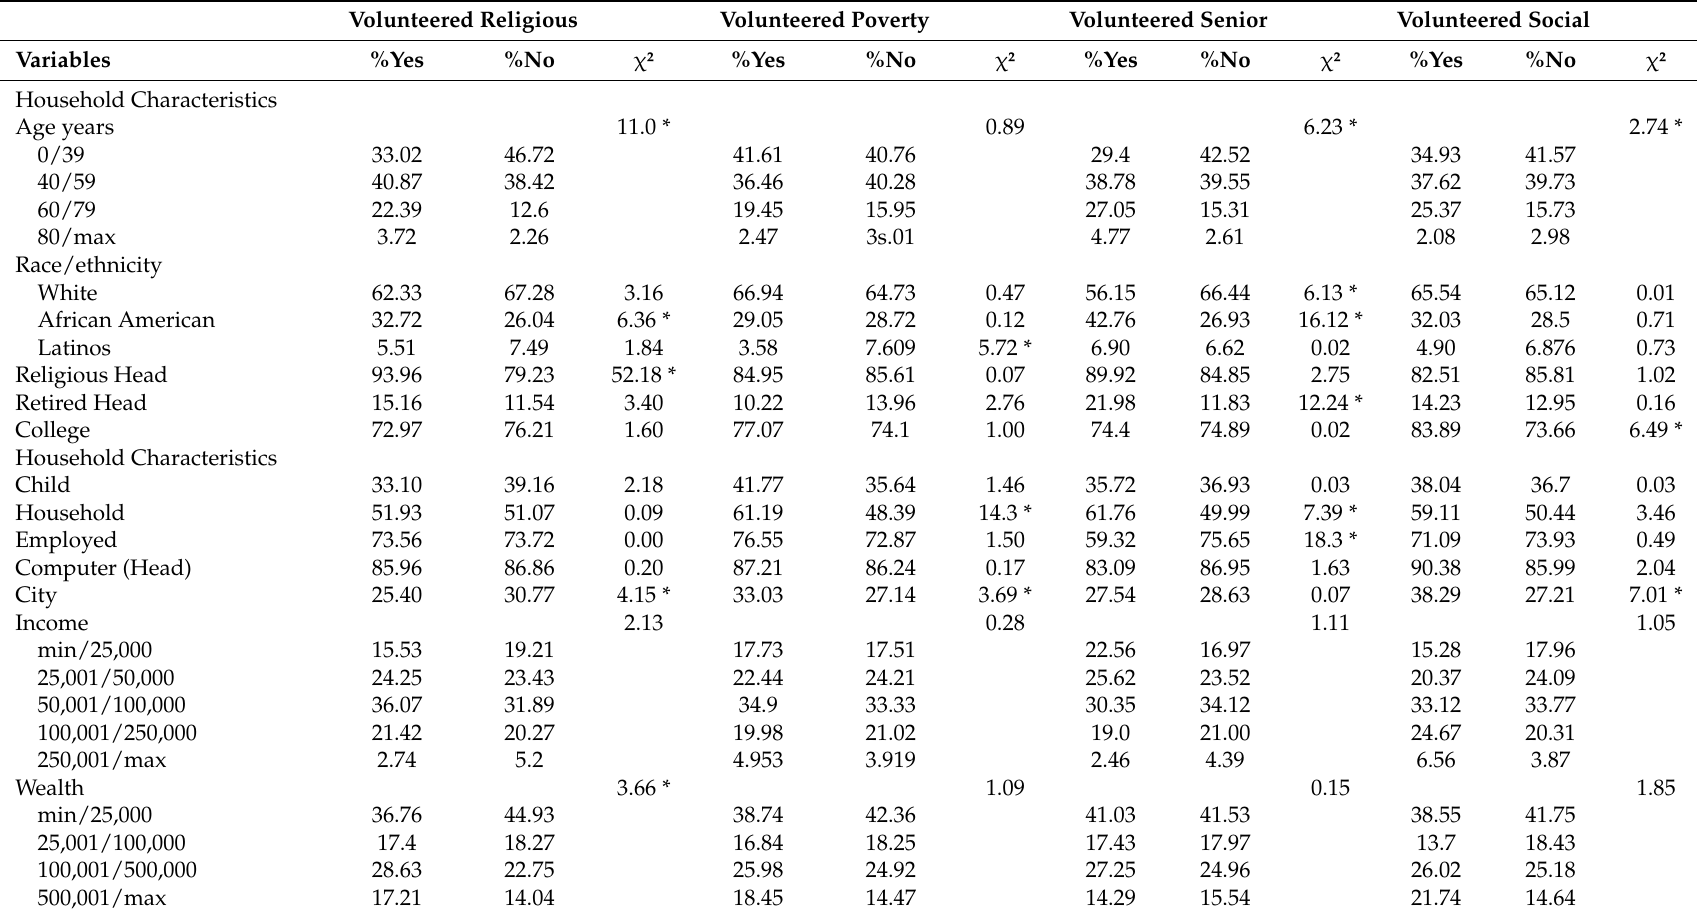
Table 4. Bivariate analysis of independent variables association with household head volunteering